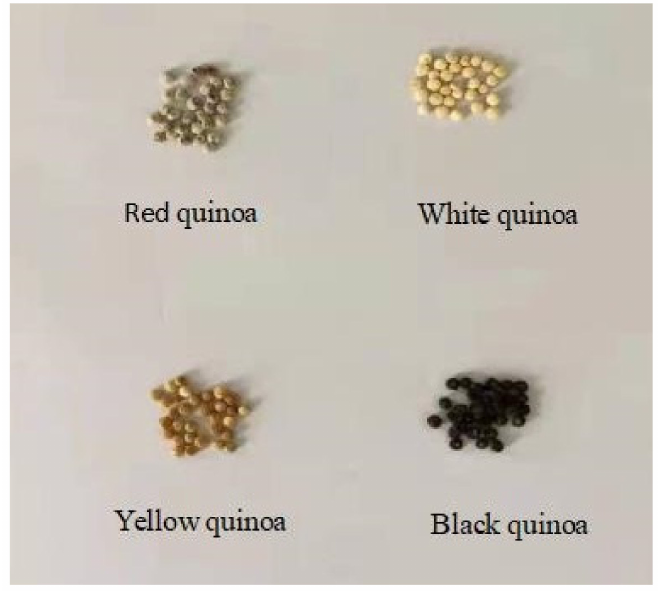
Figure 4. Red, white, black, and yellow quinoa cultivars (four quinoa